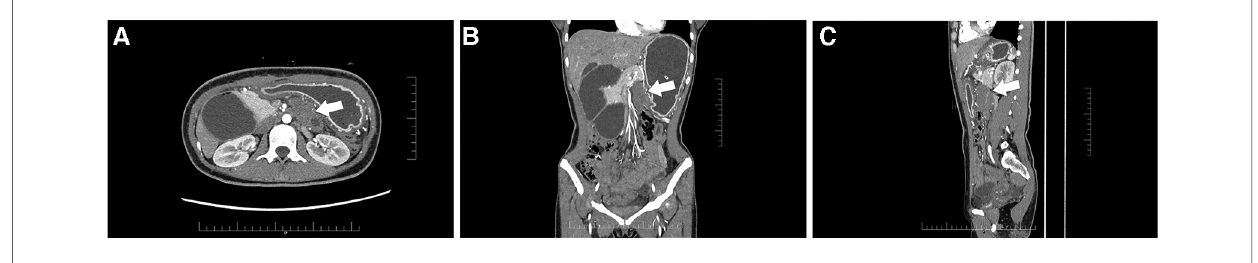
FIGURE 2 CT revealed a soft-tissue density mass about 5.4 cm*3.2 cm*5.8 cm (arrow), showing inhomogeneous density with ill-de fi ned margin, and having a non- enhancing necrotic area with poor demarcation from the surrounding intestine ( A ) axial view, ( B ) coronal view, ( C ) sagittal